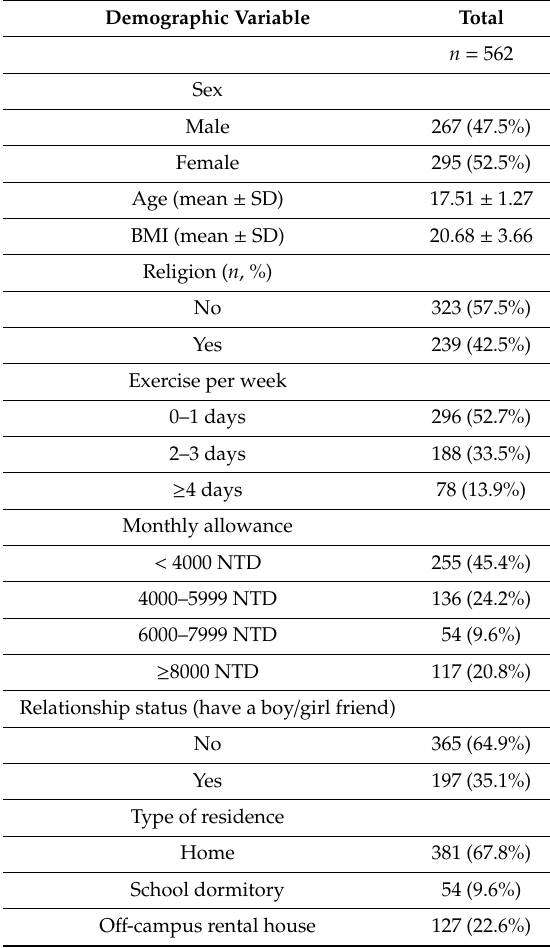
Table 1. Demography of the participants.